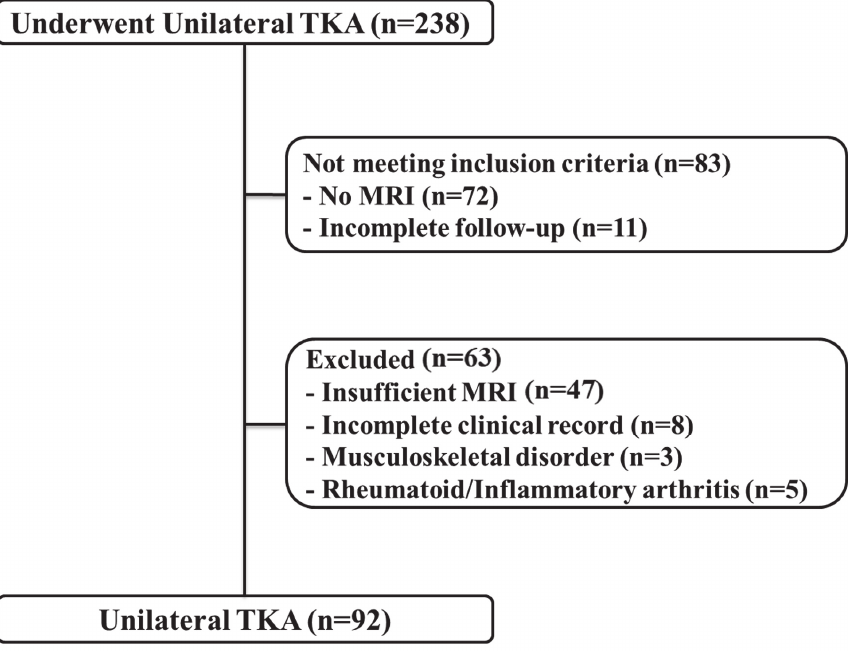
Figure 1. Flow diagram for the patients’ enrollment. Table 1. Patient